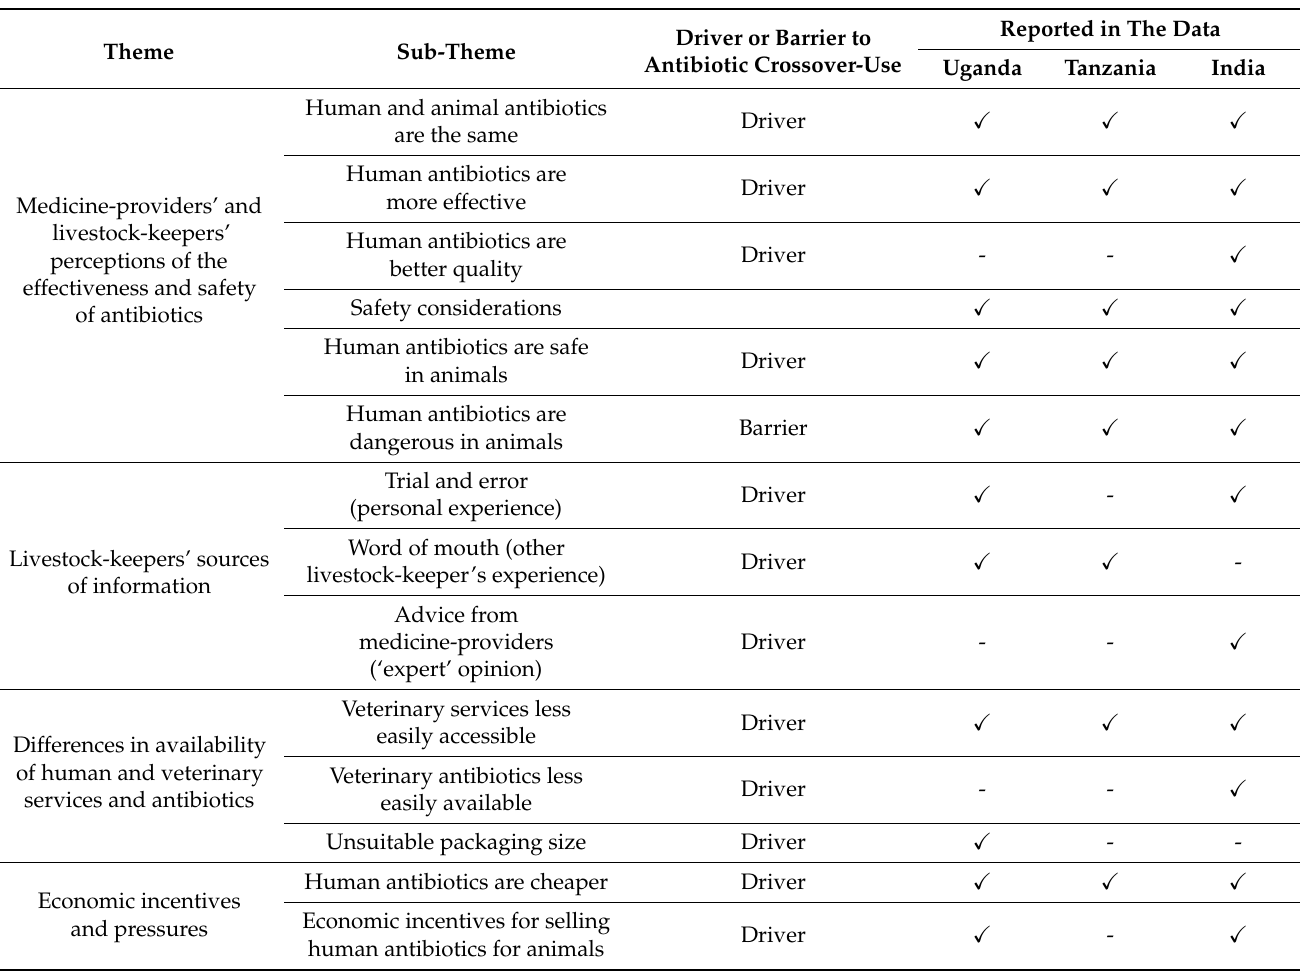
Table 3. A comparison of the themes identified as driving or deterring crossover-use of antibiotics across